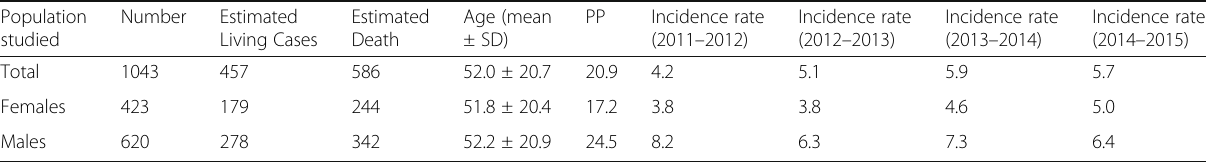
Table 1 Demographic and epidemiological data in patients with brain and other nervous system tumors Population studied